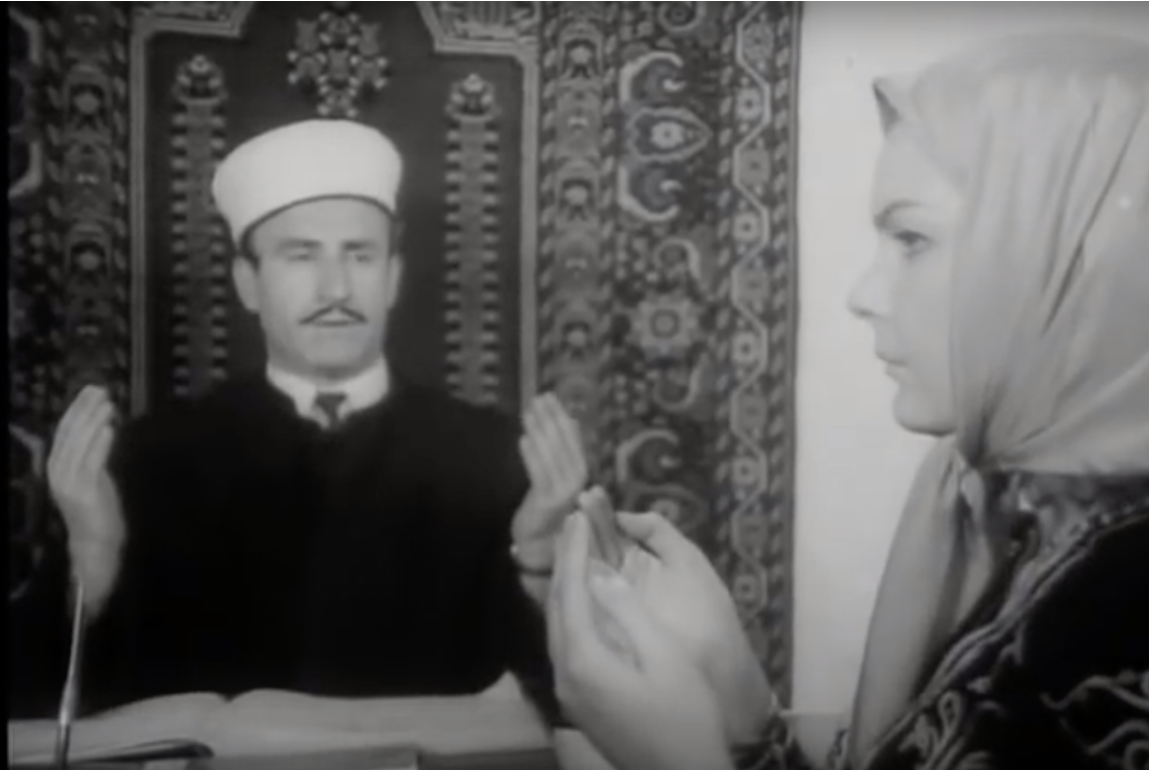
Figure 5: Eva's transformation is completed when she converts to